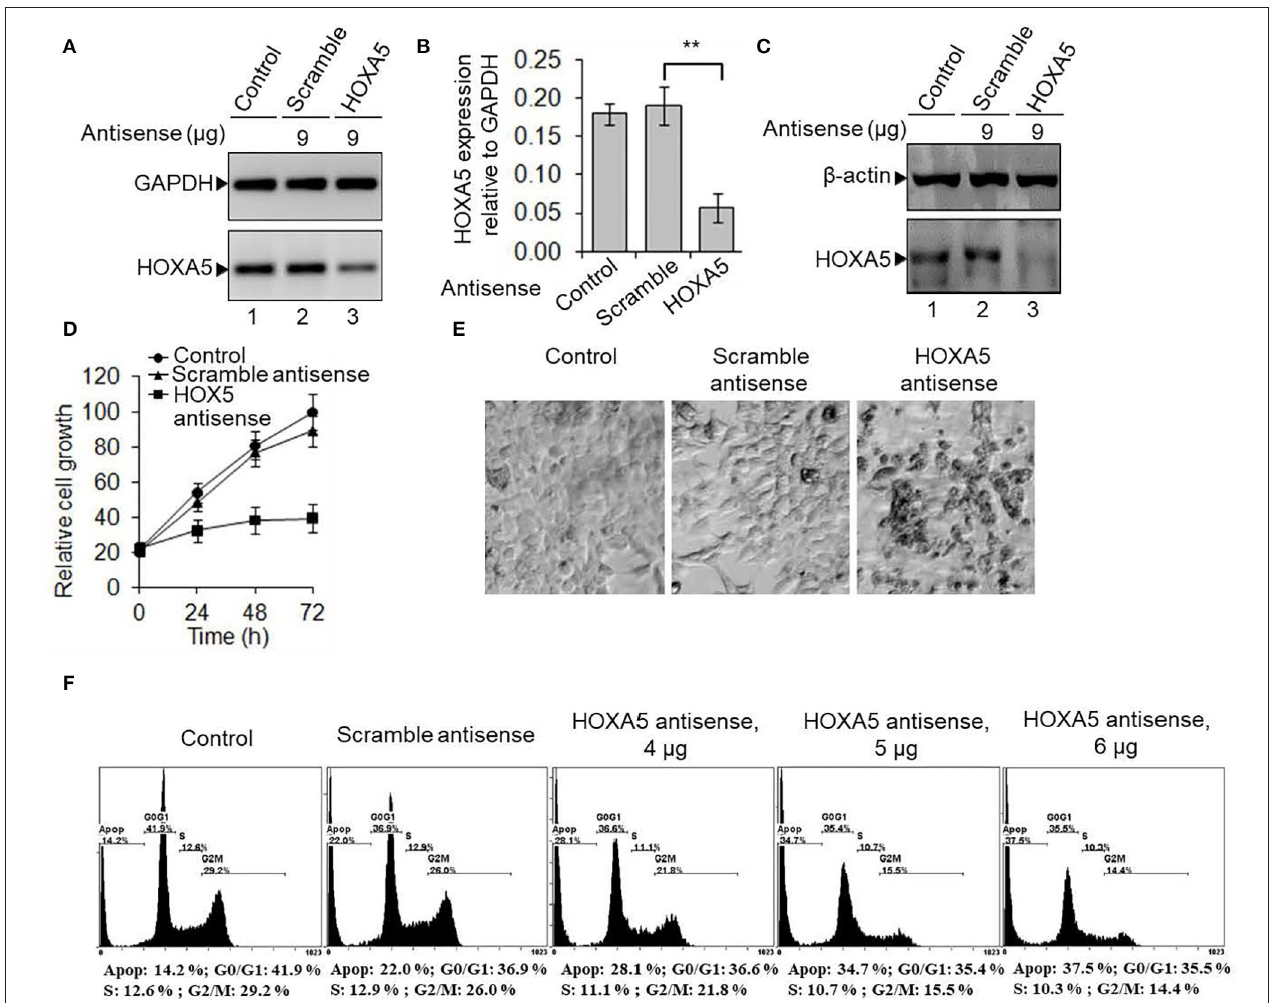
FIGURE 3 | HOXA5 knockdown affects cell viability and cell-cycle progression. (A–C) MCF7 cells were transfected with HOXA5-specific and scramble antisense for 48h, RNA was analyzed by RT-PCR with primers specific to HOXA5 ( A , quantification in B ). GAPDH was used as normalization control. Bars indicate averages ± standard errors ( n = 3). **denotes p < 0.0001 compared to scramble control. Proteins were analyzed by Western blot using HOXA5 and β -actin (loading control) antibodies (C) . (D,E) Impact of HOXA5 knockdown on cell growth and viability. MCF7 cells were transfected with HOXA5-specific and scramble-antisense oligonucleotides. Live cell numbers were counted under HOXA5 knockdown conditions for varying periods of time and plotted in (D) . Data points indicate averages ± standard errors ( n = 3). **denotes p < 0.0001 compared to scramble control. Morphologies of cells were visualized under a microscope (Nikon Eclipse TE2000-U) (E) . Bars indicate standard errors ( n = 3). (F) Flow cytometry analysis. MCF7 cells were treated with HOXA5 and scramble antisense separately for 48h and subjected to flow cytometry analysis. Panel 1: Control cells treated with no antisense, panel 2: cells treated with scramble-antisense, panels 3–5: cells treated with